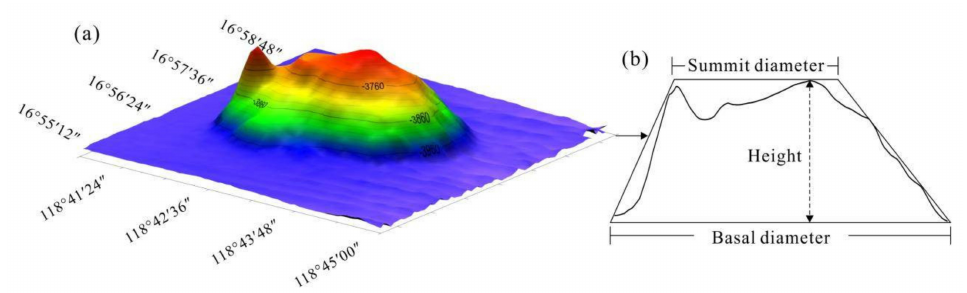
Figure 11. Schematic map of the morphological parameters of seamounts. ( a ) Three-dimensional bathymetry map of a seamount (Seamount M8); ( b ) geometry of the seamount. The extracted parameters for the seamount are marked on a schematic diagram.